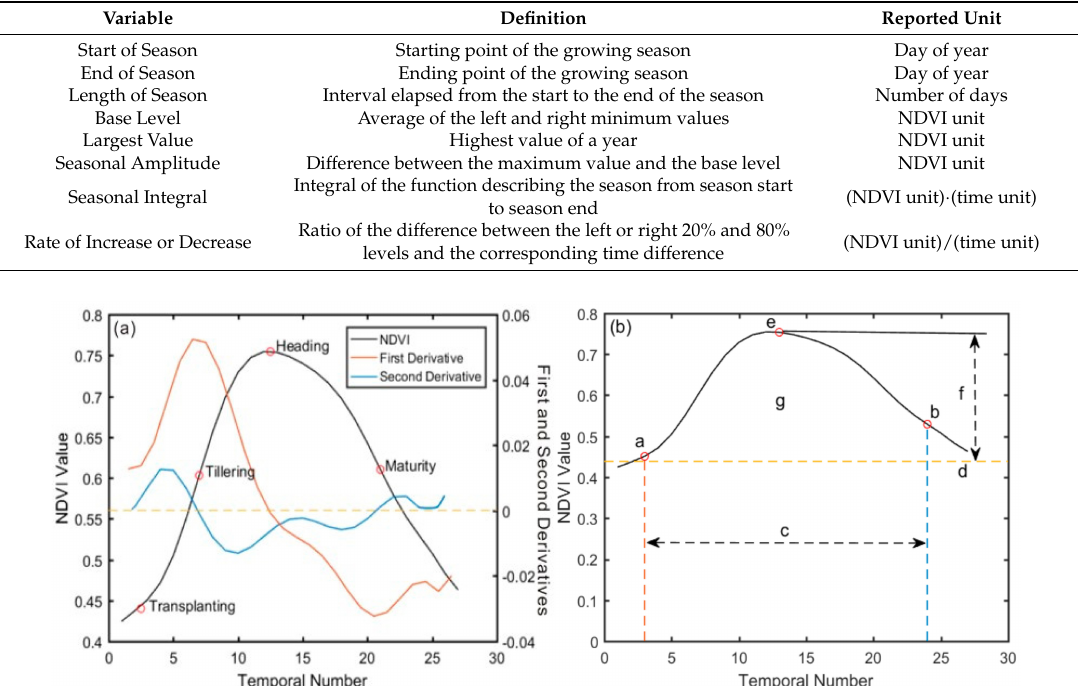
Table 3. Satellite-derived phenological NDVI metrics presented in this study.